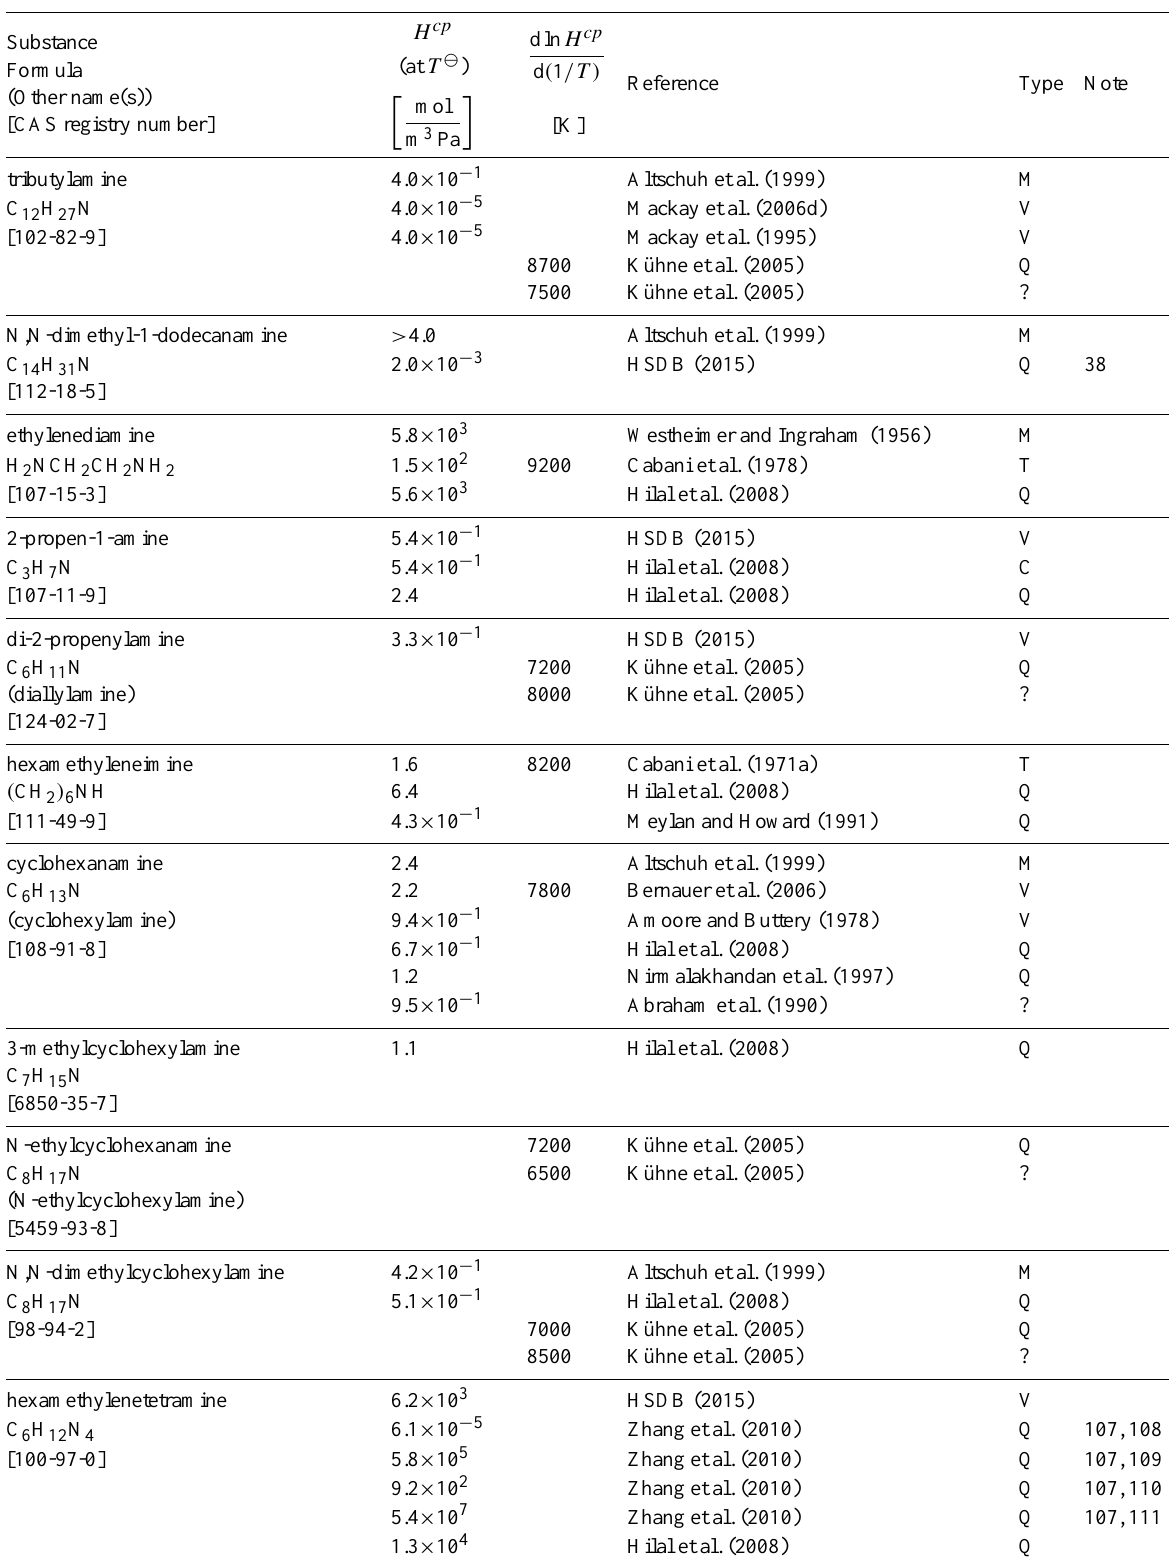
Table 6: Henry’s law constants for water as solvent